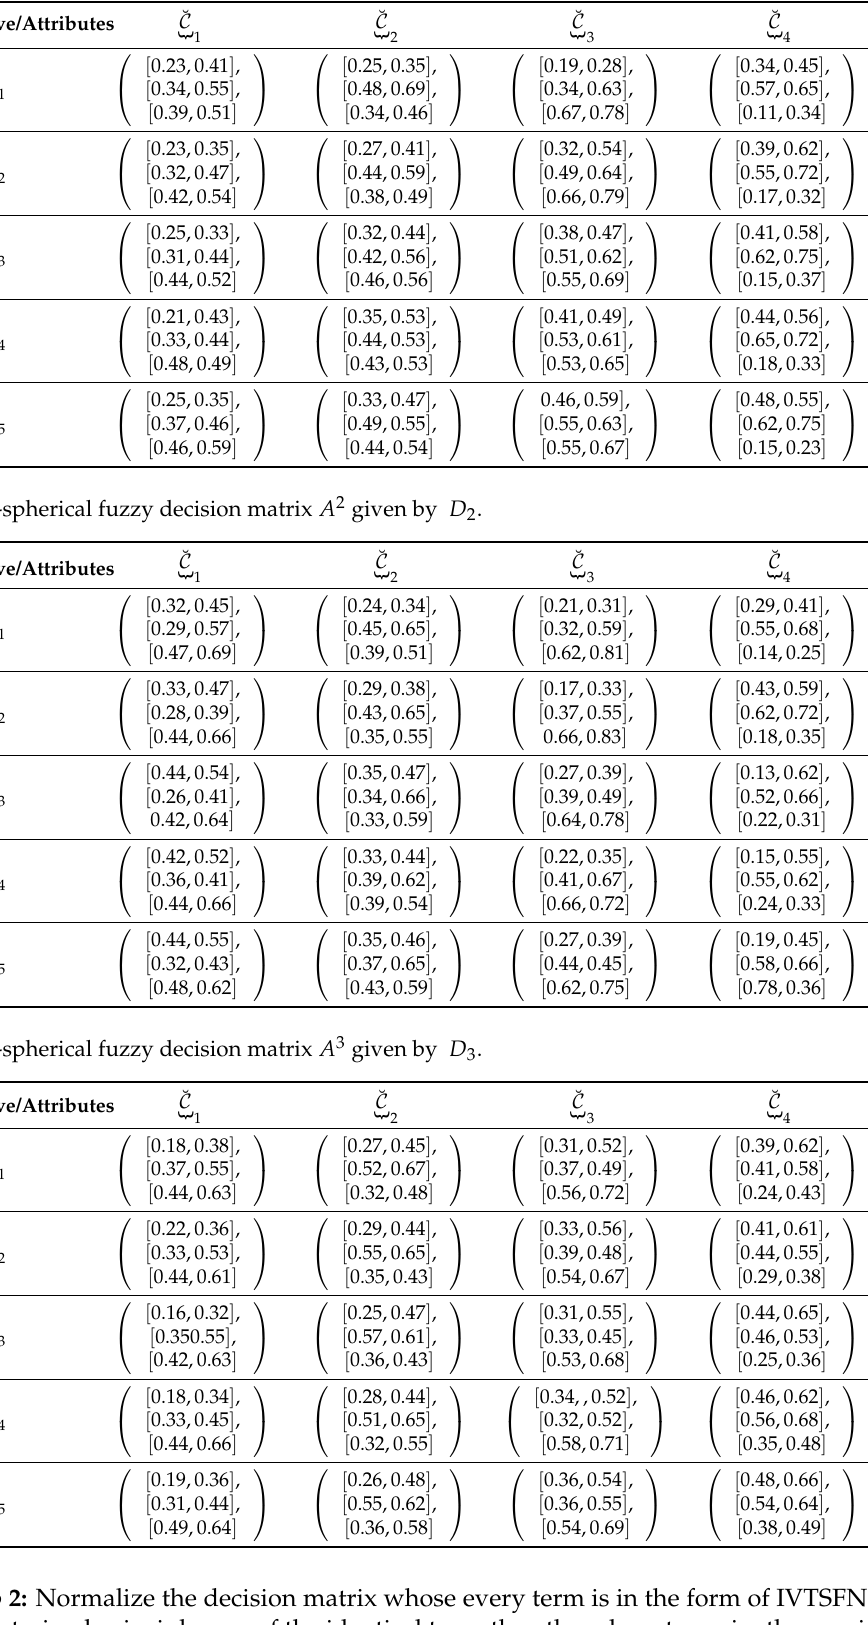
Table 1. T-spherical fuzzy decision matrix A 1 given by D 1 .